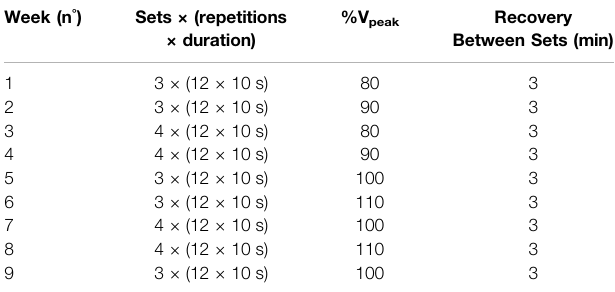
TABLE 2 | High-intensity intermittent training